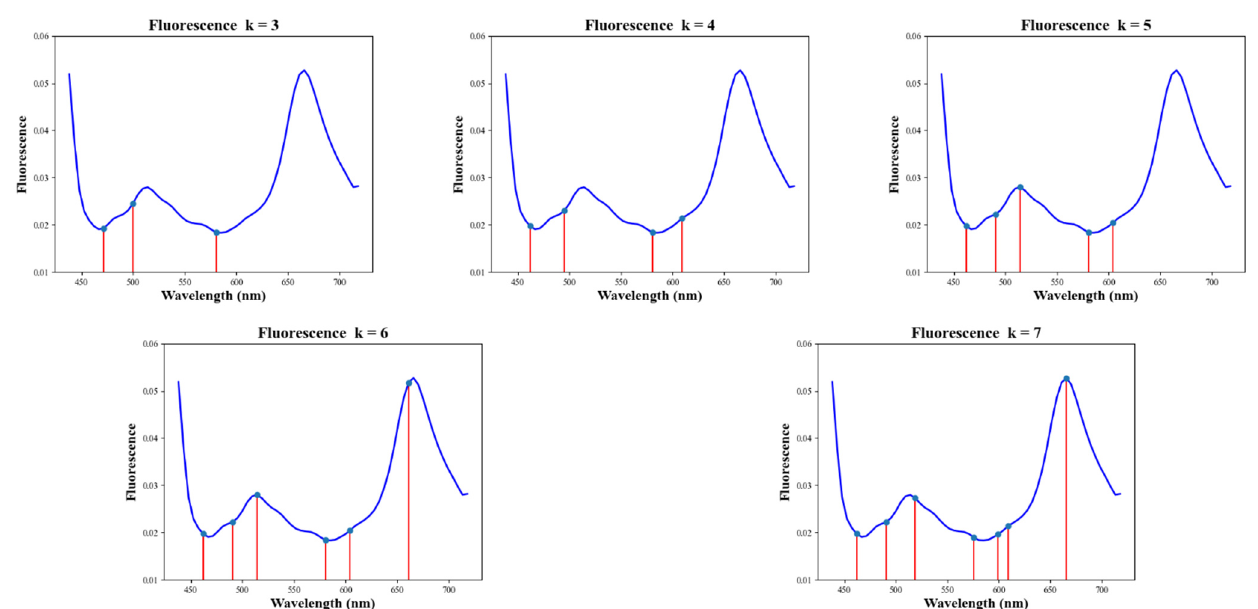
13 of 22 Figure 7. Average VNIR reflectance spectrum for one of the red snapper fillets with the optimal k = 3, 4, 5, 6, 7 wavelength